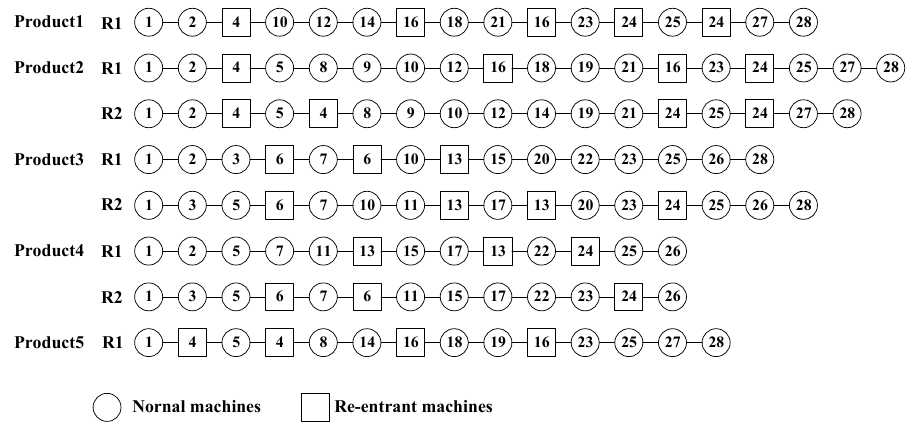
Fig. 10. Processing flow for Case 3